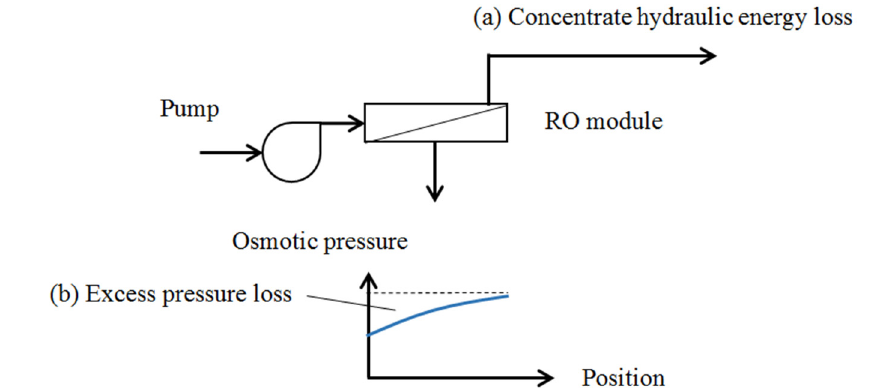
Figure 2. Essential losses in a simple Reverse Osmosis (RO) system with no Energy Recovery Device (ERD). Allowing for these losses only, a semi-ideal specific energy consumption SEC sideal is defined for the